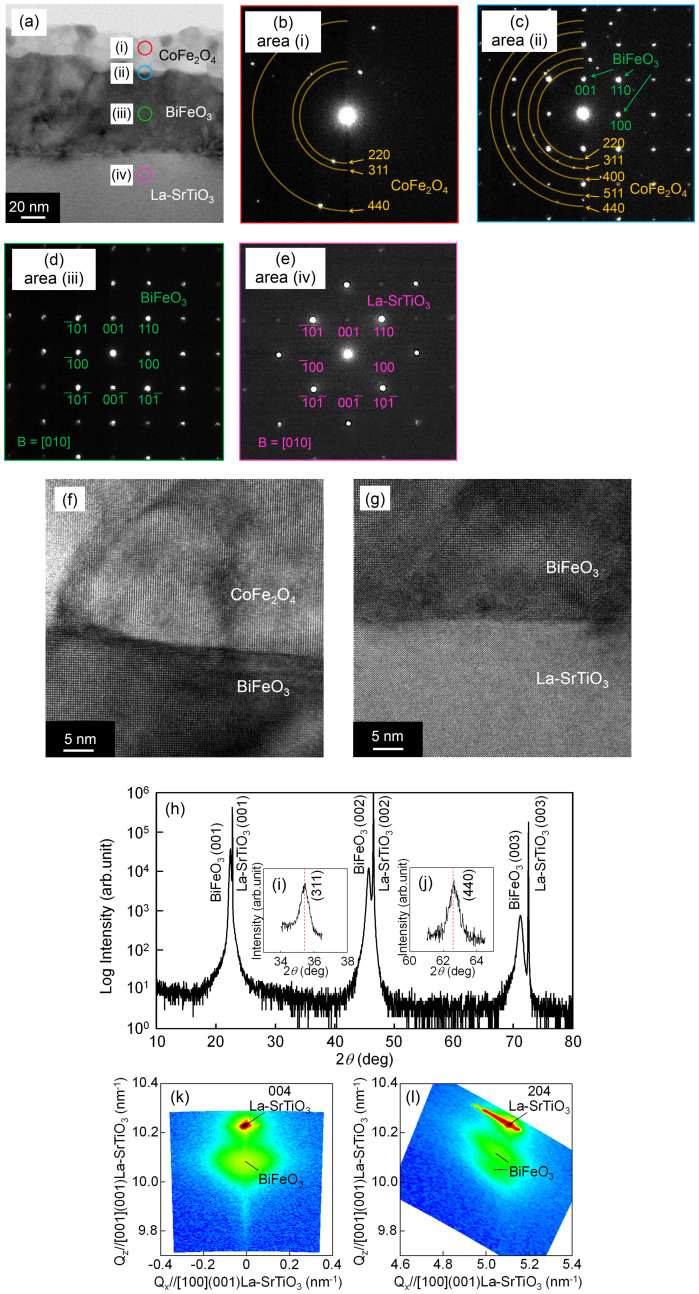
(a) Cross-sectional TEM image of a wide area of the sample, (b)(e) electron-diffraction patterns taken from circles (i)(iv), and cross-sectional high-resolution TEM images taken at the (f) BiFeO3/La-SrTiO3 and (g) CoFe2O4/BiFeO3 interfaces. (h) Out-of-plane /2 XRD pattern, GI-XRD patterns around (i) (311) and (j) (440) of the CoFe2O4 diffraction peaks, and RSMs around the (d) 004 and (e) 204 spots of the (001)-epitaxial-BiFeO3/CoFe2O4 film.